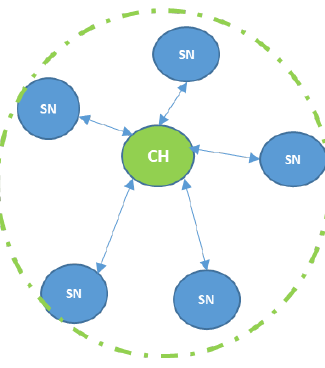
Figure 1. A typical wireless sensor network (WSN).